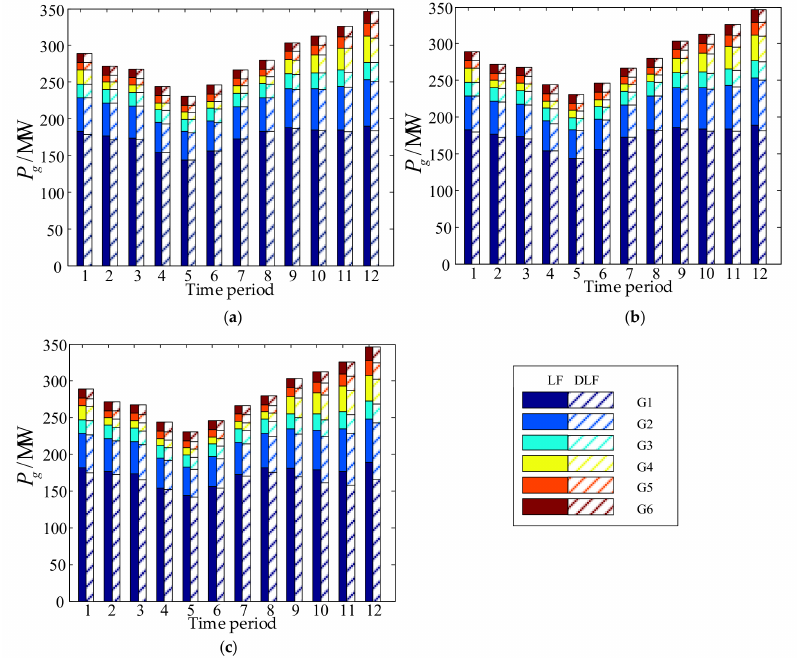
Figure 4. Dispatch results of generators in IEEE 30-bus system with different confidence levels.